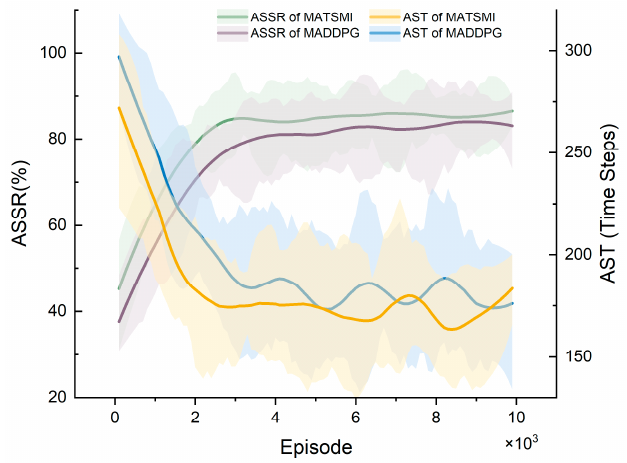
Figure 4. Comparison of ASSR and AST curves of MATSMI and MADDPG algorithms.